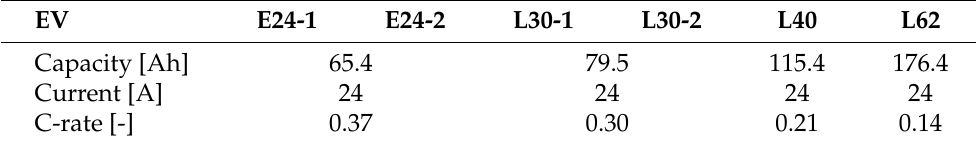
Table 3. Current and C-rate during the constant current phase of the charging process.